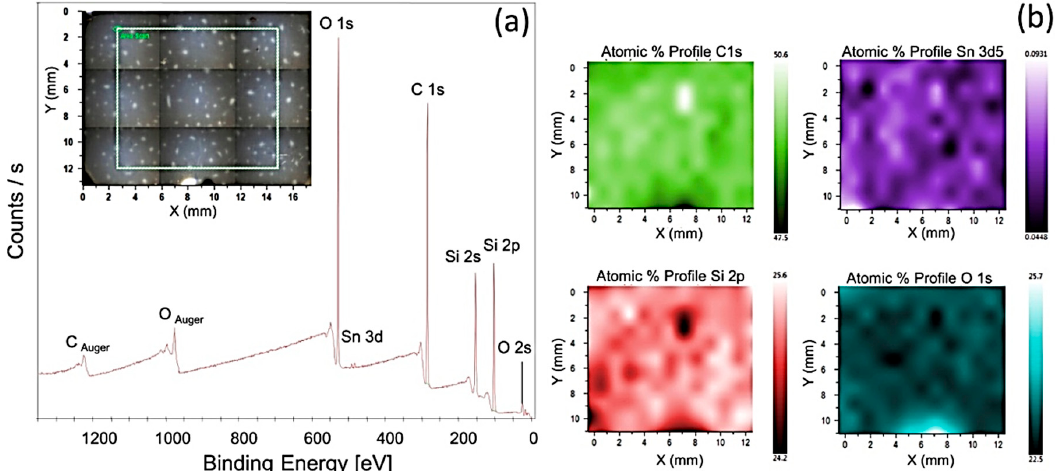
Figure 5. ( a ) XPS spectra of MRE with 20 wt% CIPs, demonstrating carbon, oxygen, silicon, and tin elements in the selected area, presented in inset figure. ( b ) XPS maps and atomic percentages of elements for the selected area [23] (reprinted with permission from Elsevier TM ).